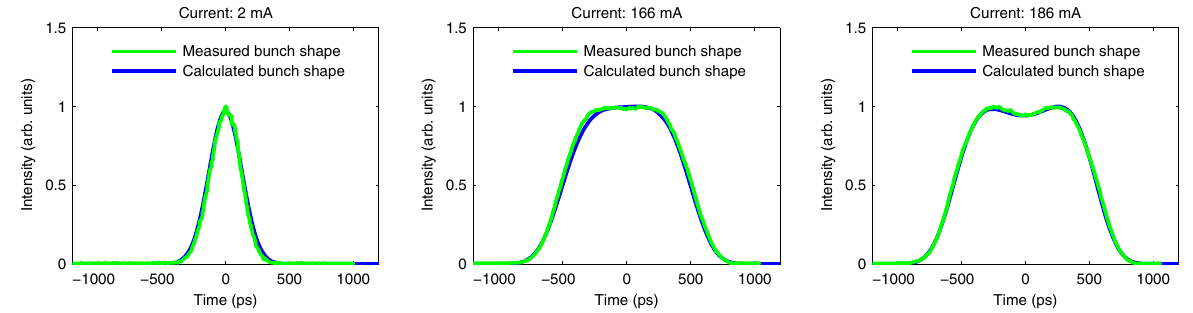
FIG. 9. Examples of measured bunch shapes compared to calculated density distributions. The calculations are based on the full self-consistency approach. Gaussian bunch (left) with natural bunch length at low currents. Elongated bunch (middle) close to flat potential conditions for medium currents. At higher currents (right) the bunch is overstretched by the harmonic